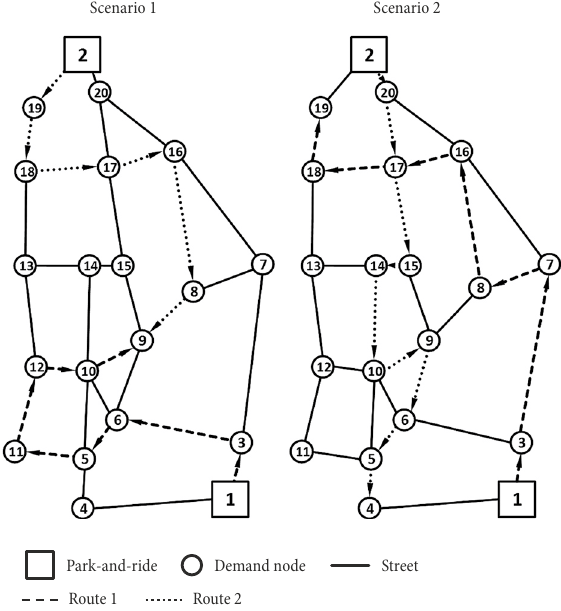
Fig. 6. The plan of existing urban bus route